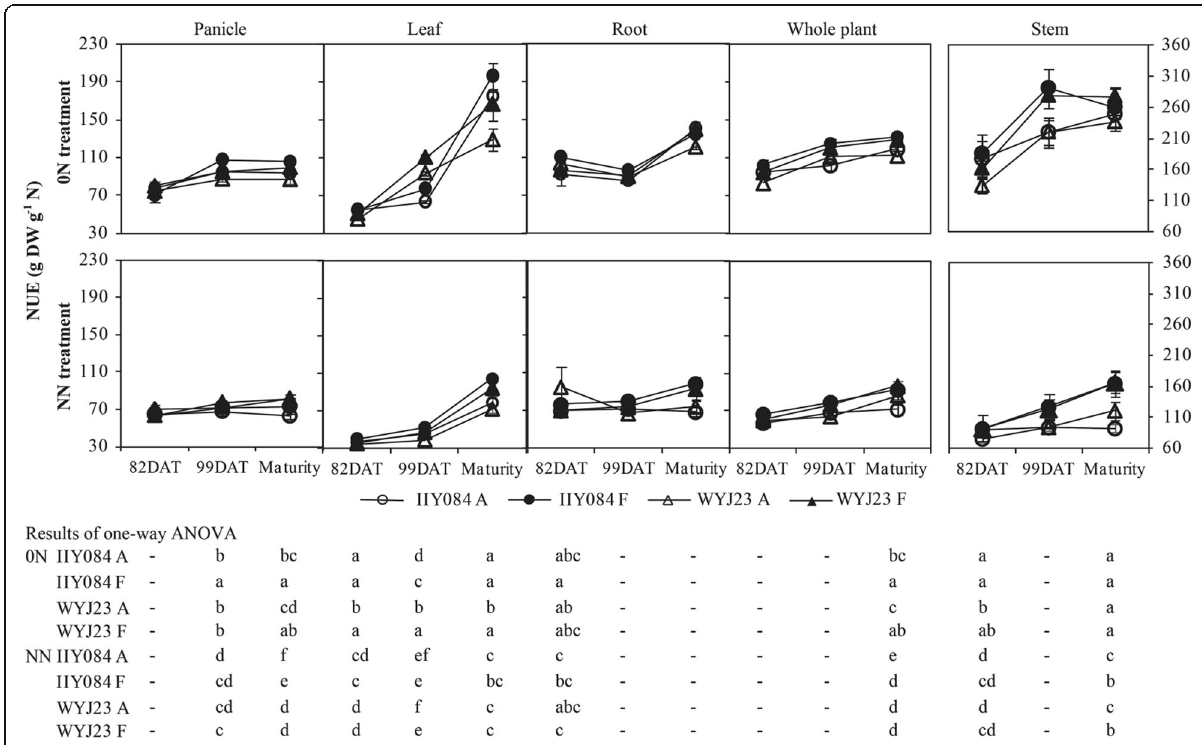
Fig. 3 The N use efficiency of four tissues and whole plants of two cultivars (IIY084 and WYJ23) subjected to ambient (A) and elevated [CO 2 ] (F) at none (0N) and normal N levels (NN) at three stages (different letters in each column indicated significant differences in each tissue among eight treatments at each sampling date according to LSD at 5% level. -; one-way ANOVA was not applied since no significant interactions of [CO 2 ], cultivar, and N were